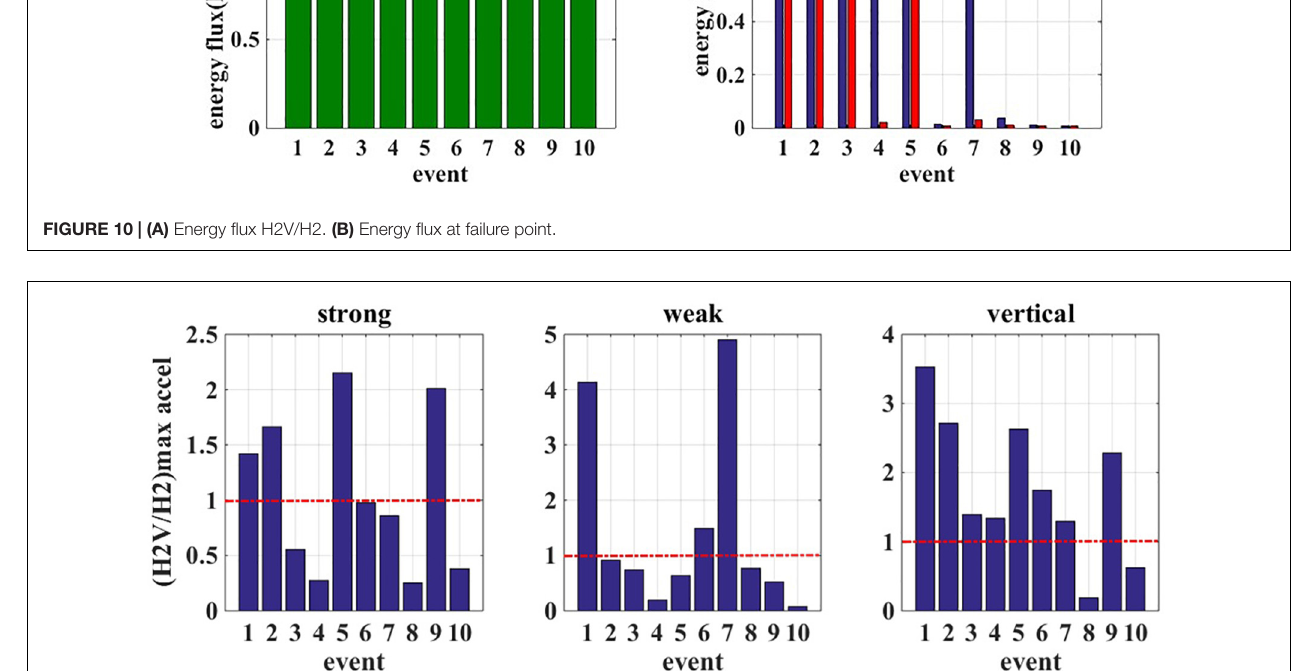
FIGURE 11 | Ratio of maximum roof acceleration between H2V and H2